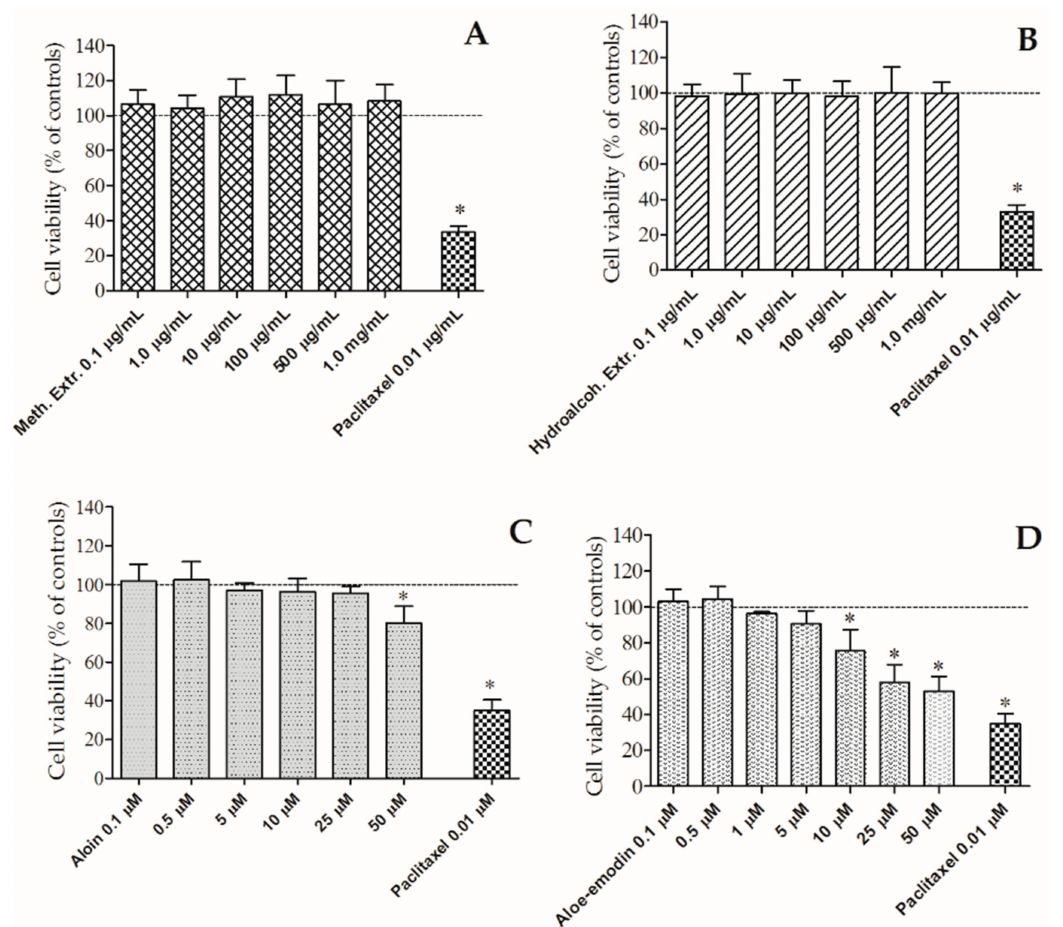
Figure 4. Activity of the methanolic (Meth.) ( A ) and hydroalcoholic (Hydroalcoh.) ( B ) extracts, and aloin ( C ) and aloe-emodin ( D ) on cellular viability of human colon adenocarcinoma (HT-29) cells. Paclitaxel was used as positive control. Extr: extract. * p < 0.05 vs. controls (cell viability without